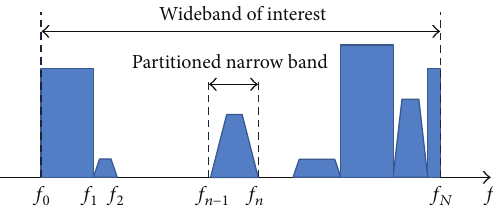
Figure 13: A wideband spectrum seen as a train of narrowband signals and presenting frequency